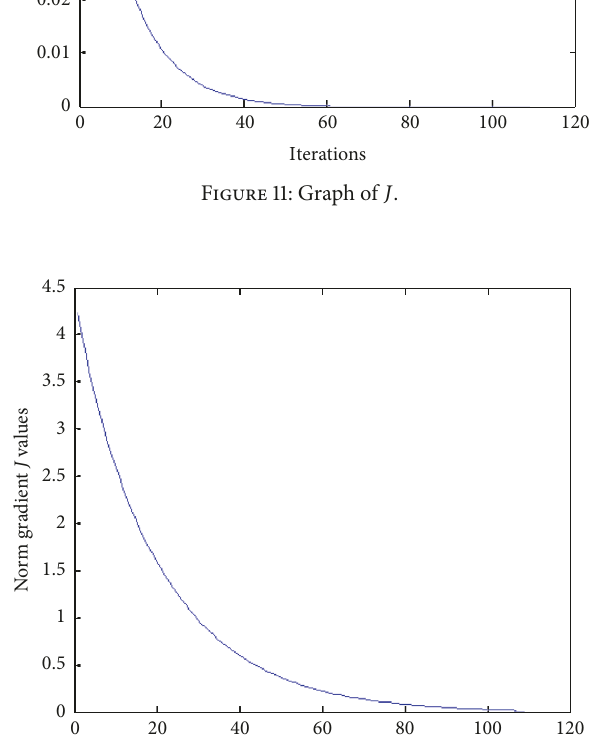
Figure 12: Norm of gradient of 𝐽